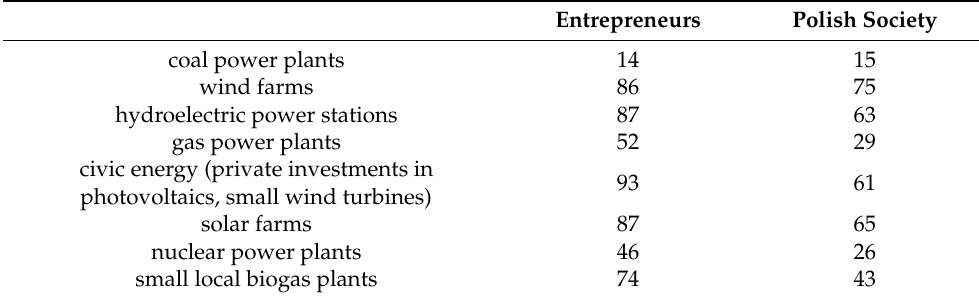
Table 7. Should the government invest in . . . for the sake of the Polish economy and rapid economic development? (in percentage